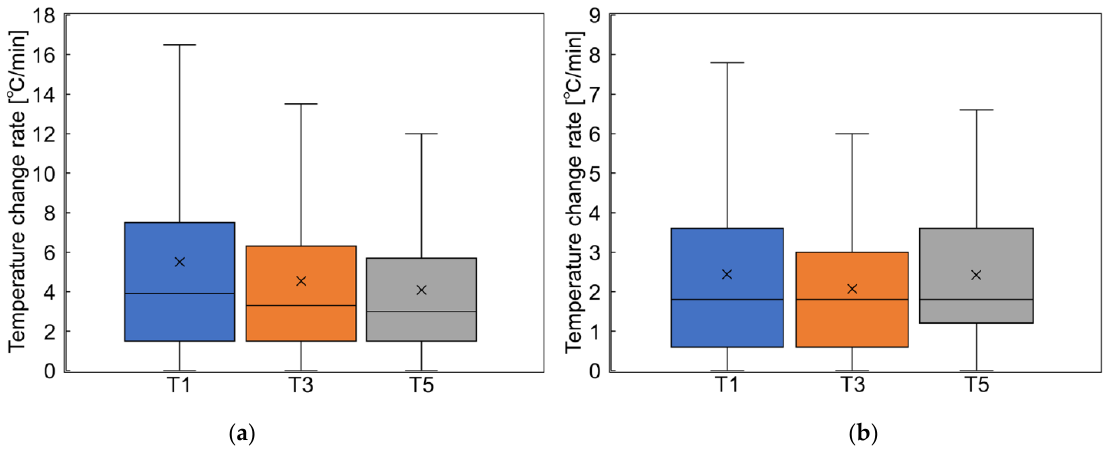
Figure 12. Box plots of the absolute temperature change rate | dT ave / dt| at T1, T3, and T5 on the VIPV module: ( a ) small van and ( b ) sedan.